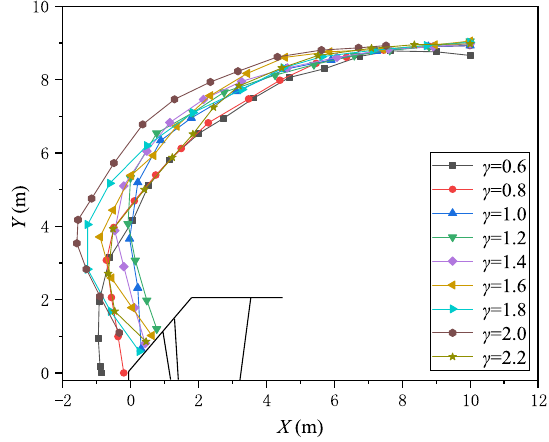
Fig. 17 Fusion diagram of the body to be drawn (purple region) and force chains in the initial drawing process (unit: N) ( γ = 0.6)